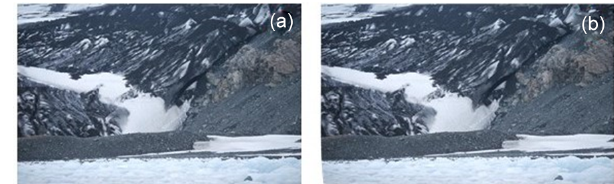
Figure 5. (a) Original image obtained with non-metric camera. (b) The rectified image, after applying the distortion function. At the lower left corner of the image an area affected by radial distor- tion can be seen.